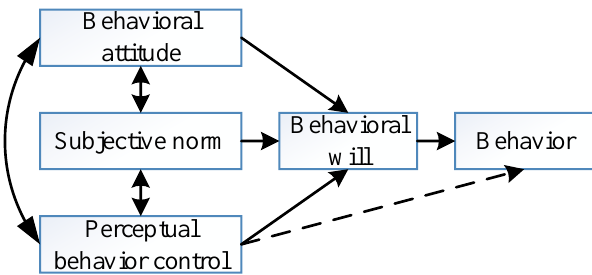
Figure 3. Theoretical Model of Planned Behavior.